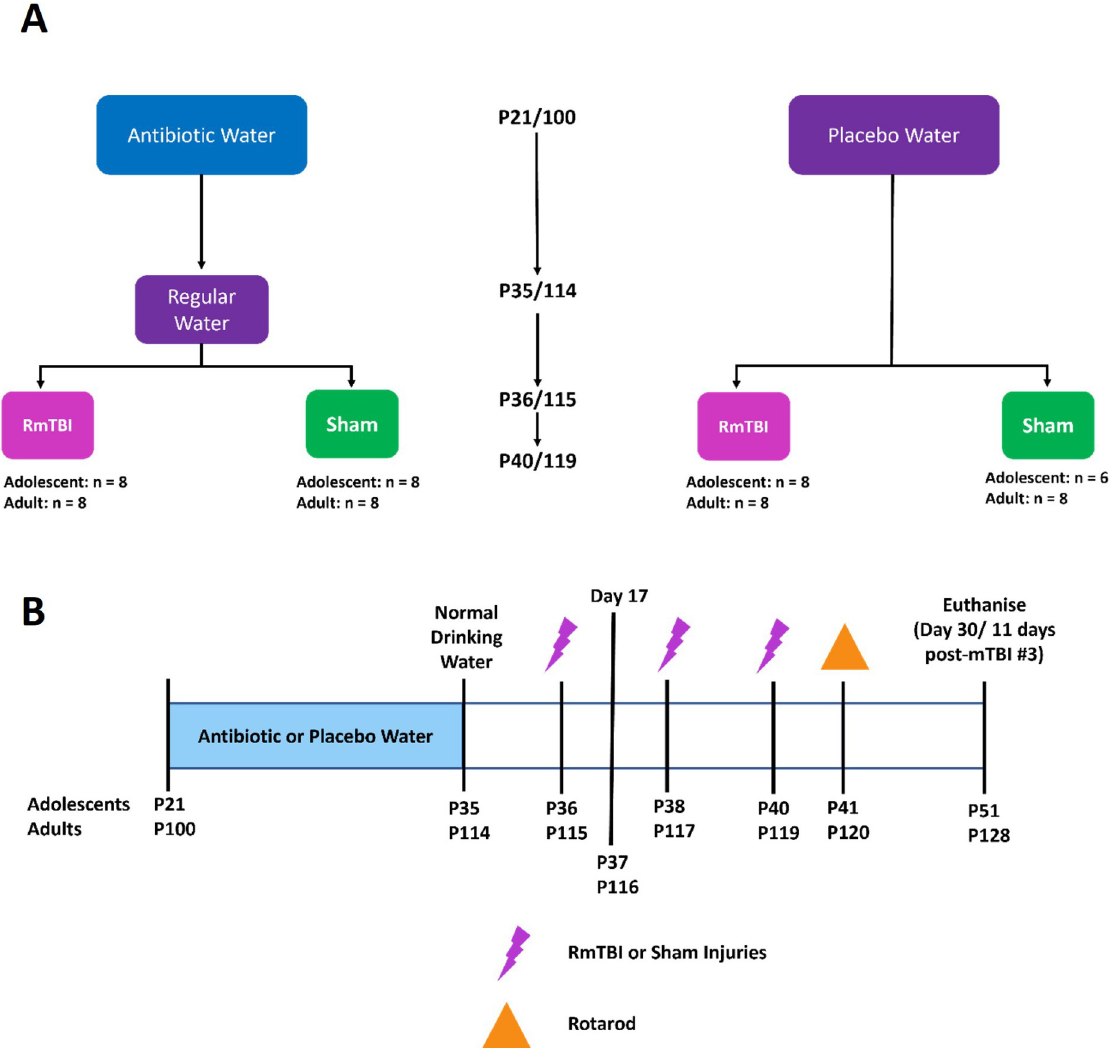
12:12 hr light:dark cycle, with lights on at 0600, in a temperature controlled (21˚C) facility. At postnatal (P) day 21 and 100, adolescent (n = 31) and adult (n = 32) Sprague Dawley rats, were randomly assigned to either antibiotic (17 adolescents, 16 adults) or standard auto- claved drinking water (14 adolescents, 16 adults); equal males and females were included in each group. The antibiotic cocktail administered over the 14 days in their drinking water consisted of ampicillin (1g/L), vancomycin (500mg/L), imipenem (250mg/L), metronida- zole (1g/L), and ciprofloxacin HCL (20mg/L). This antibiotic cocktail was previously described in Hoban et al, 23 to effectively deplete the gut microbiota. Rats on antibiotic water were transferred back to standard autoclaved drinking water on P36/115 (adolescent/adult) for the remainder of the study. See Fig 1 for group sizes and experimental timeline. Group sizes were determined with sufficient a priori statistical power using effect sizes generated from similar studies within our